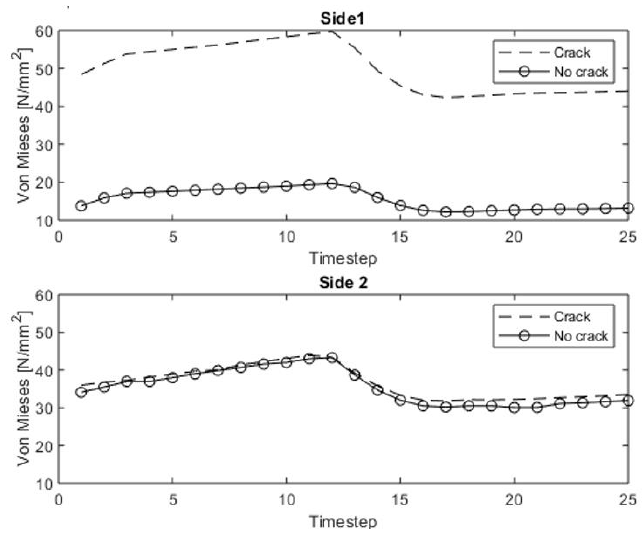
Figure 12. Side 1 ( Top ) and side 2 ( Bottom ) plotted with the nominal stress trend, to better highlight the